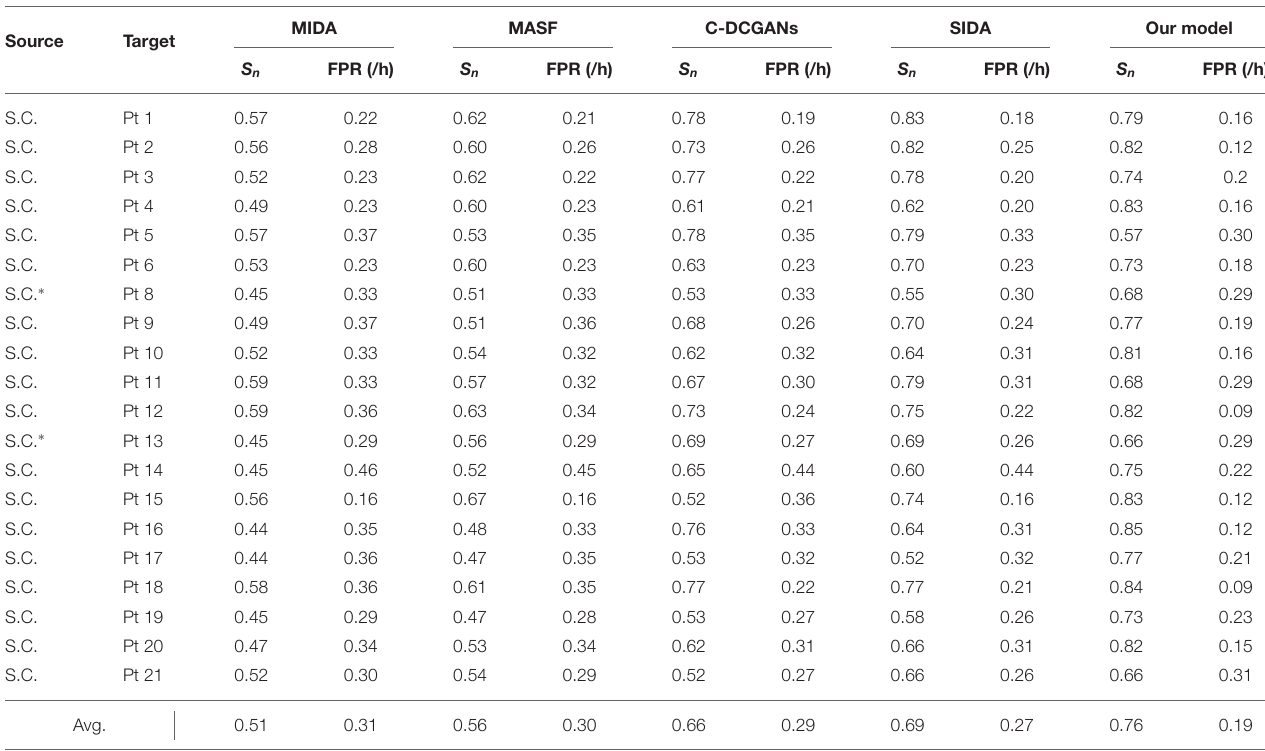
TABLE 5 | Results compared with DA methods on the Freiburg Hospital database. Source